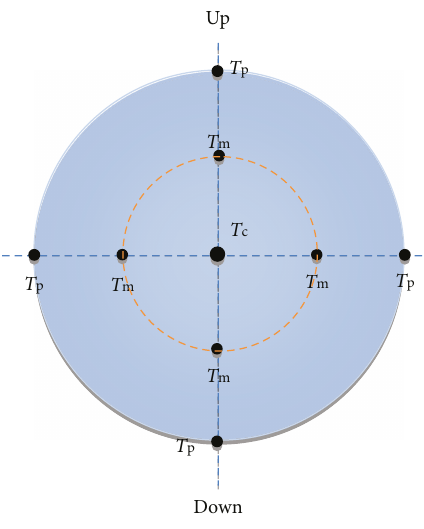
Figure 1: The schematic diagram for the measurement of corneal thickness. T is the measurement point for CCT, T is the c m measurement point for MCT, and T is the measurement point p for